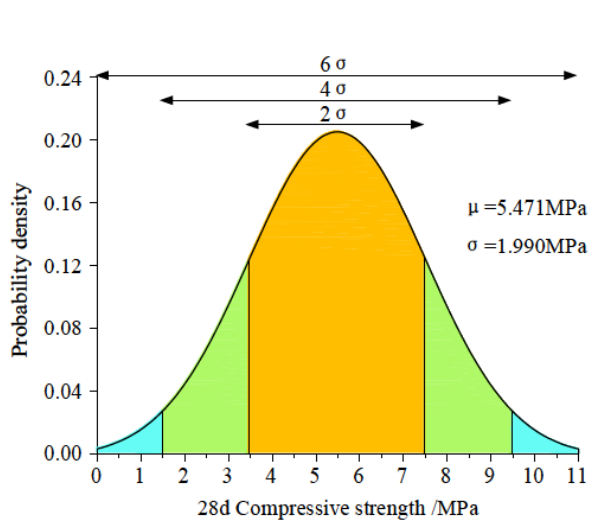
Figure 5: Statistical characteristics of 28d compressive strength